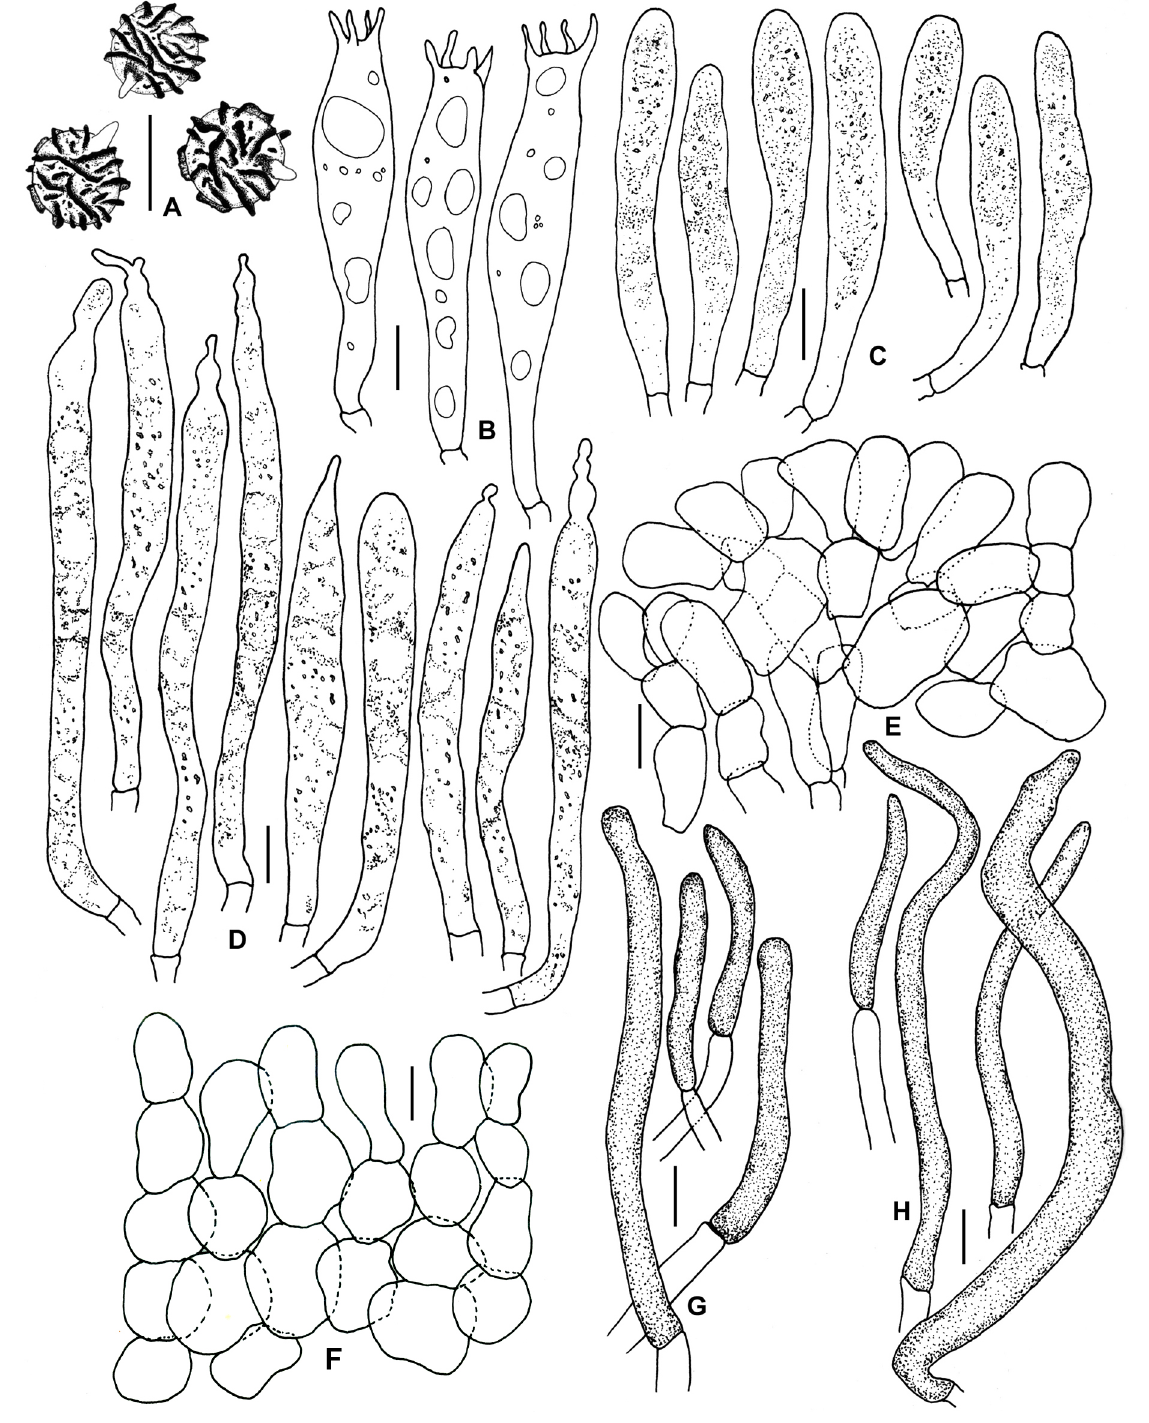
Fig. 3. Russula indosenecis A.Ghosh, D.Chakr., K.Das & Buyck sp. nov. (from holotype, AG-21-06A ). A . Basidiospores. B . Basidia. C . Hymenial cystidia near the lamellae edges. D . Hymenial cystidia on lamellae sides. E, G . Elements of the pileipellis near the pileus margin: hyphal terminations and pileocystidia. F, H . Elements of the pileipellis near the pileus center: hyphal terminations and pileocystidia. Scale bars: A–H = 10